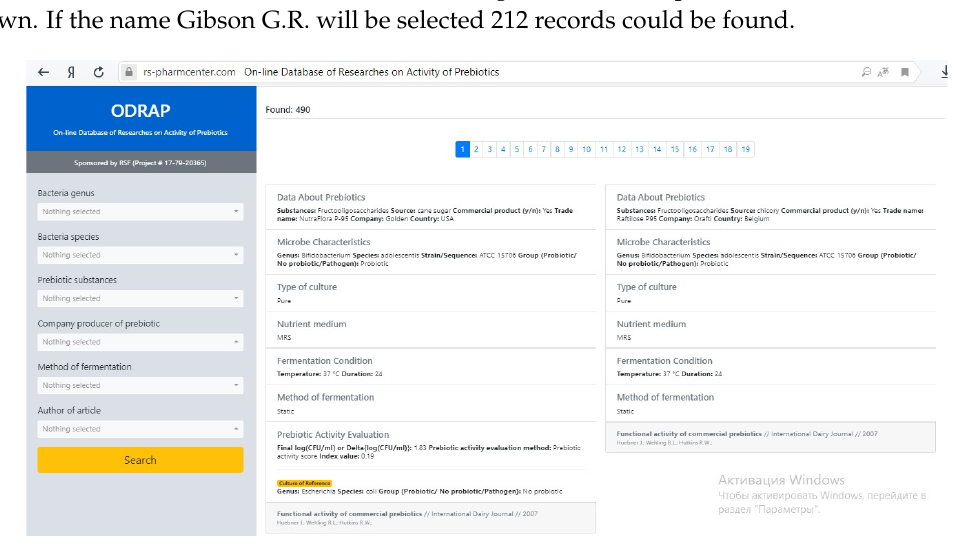
Figure 5. The main page of the Web-application of ODRAP database.